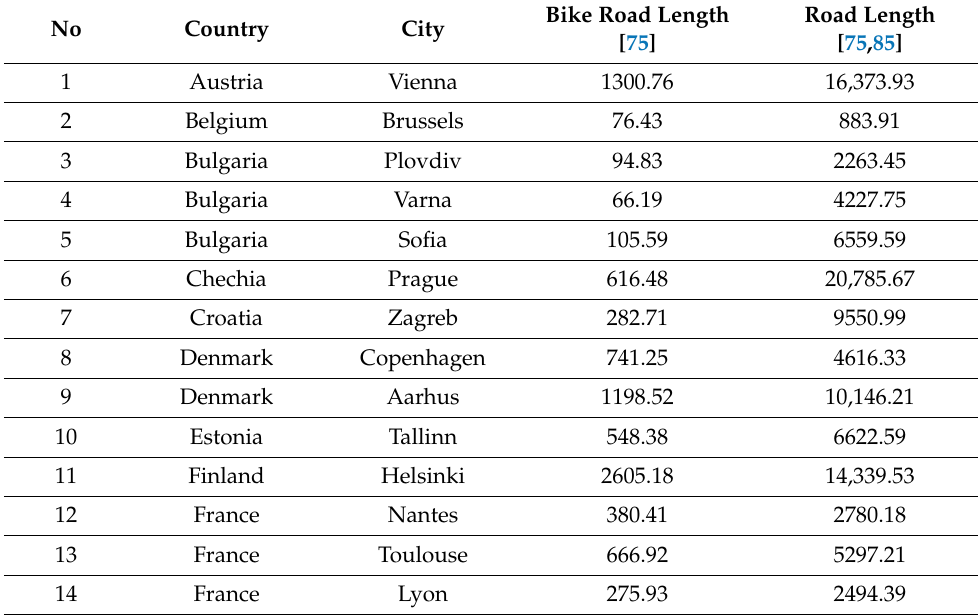
Table 2. Bike roads in European Union smart cities that are best adjusted for